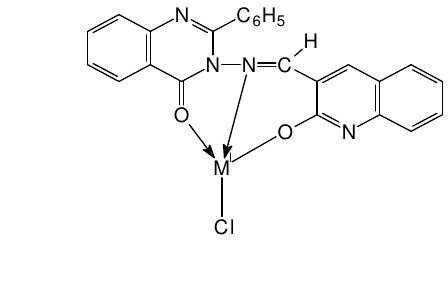
Figure 3 . Structure of complex. Figure 4 . Structure of complex. M ′ = Zn(II), Cd(II) and